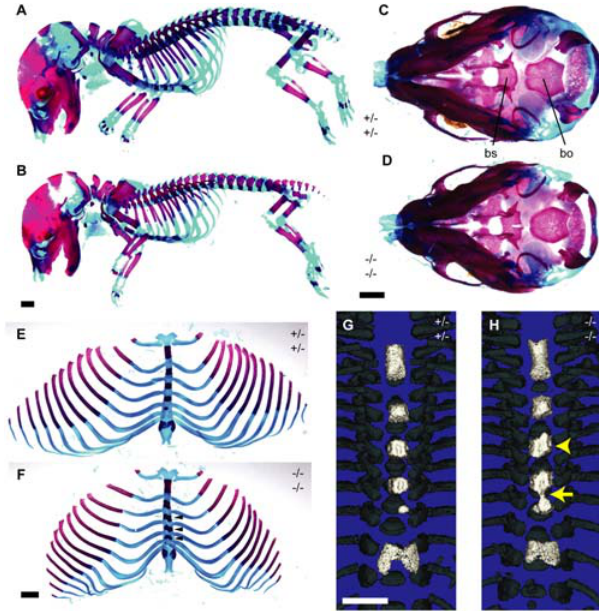
Figure 4. Embryos deficient for both Sulf1 and Sulf2 had several distinct defects in bone development. (A–F) Representative images of E18.5 littermate control Sulf1 + / 2 Sulf2 + / 2 (A, C, E, G) and Sulf1 2 / 2 Sulf2 2 / 2 (B, D, F, H) fetuses double-stained with alcian blue and alizarin red to demonstrate skeletal elements. (A, B) Whole-mount images demon- strating the reduced size of the double mutant skeleton. All bones are present, and no obvious fusion defects are apparent in any class of joints. (C, D) Skulls viewed from the posterior side. Note the hole in the dorsal side of the basisphenoid bone of the Sulf1 -/ 2 Sulf2 2 / 2 skeleton (to the right in D). Also note that the palate appears to be developing